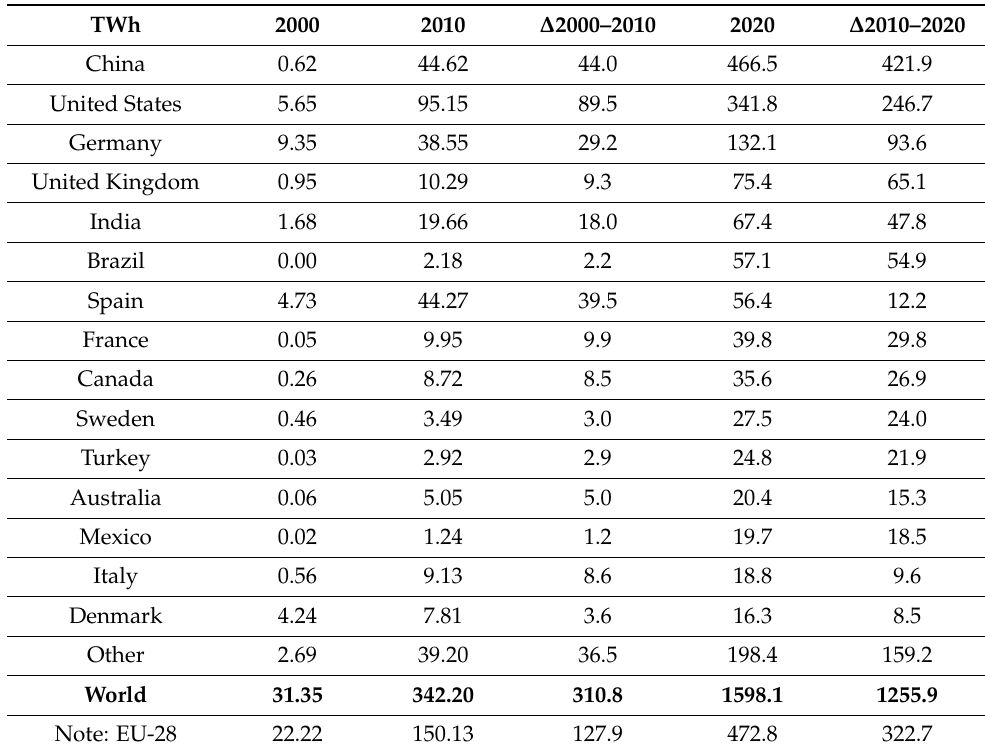
Table 8. Wind turbine electricity generation (TWh) (based on